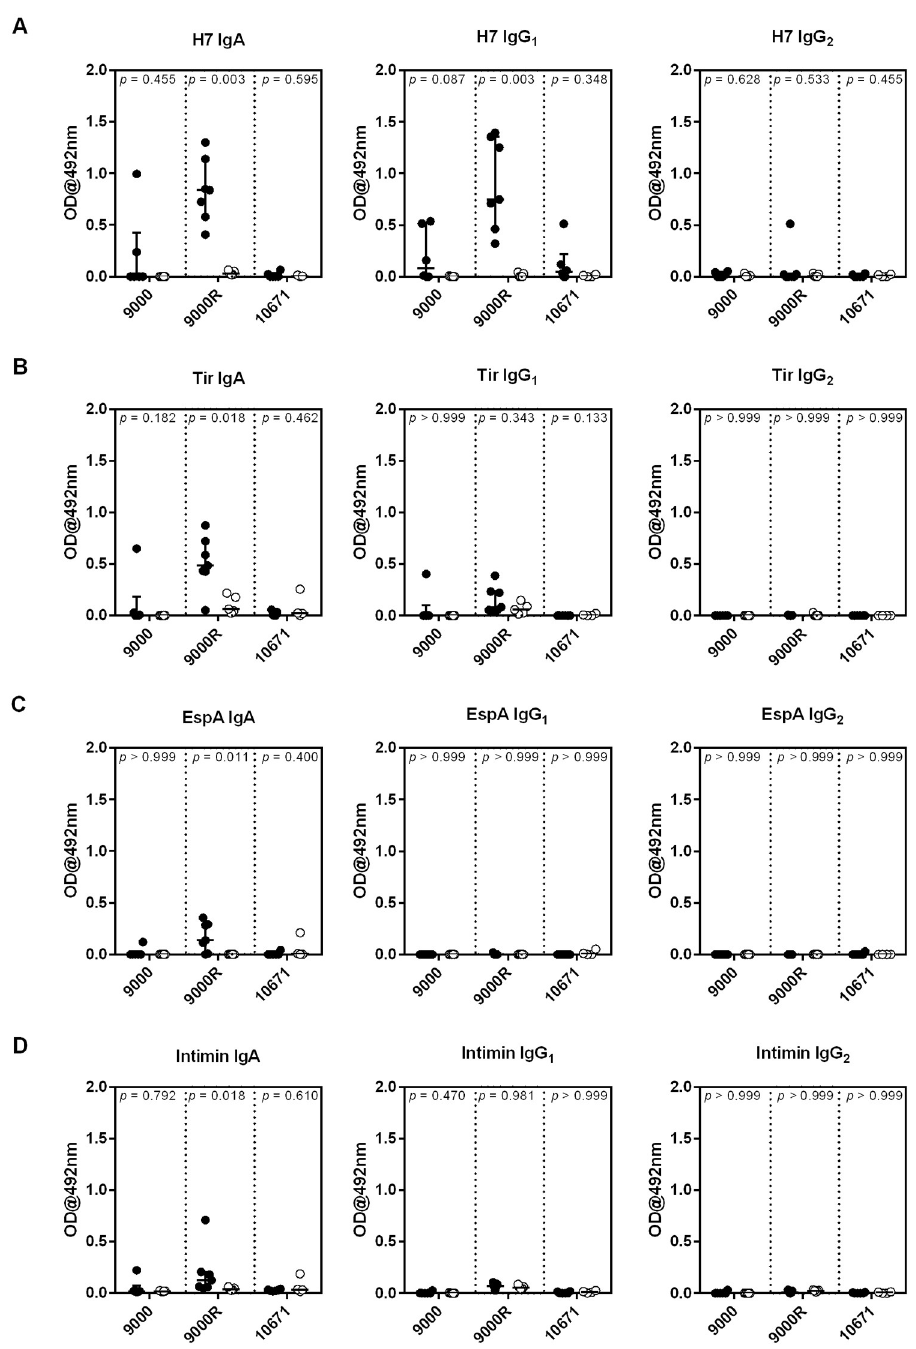
Fig 5. Enhanced rectal antibody responses to E . coli O157 antigens following challenge with a Stx2a + E . coli O157 strain. Antibody Secreting Cell (ASC) probes were generated from rectal lymph node cells isolated at post-mortem from calves orally challenged with ~10 9 cfu of E . coli O157 strains 9000, 9000R, and 10671 and from unchallenged control calves. Levels of (A) H7-specific; (B) Tir-specific; (C) EspA-specific and (D) Intimin-specific IgA, IgG 1 and IgG 2 within ASC probes quantified by ELISA. Each symbol represents an individual animal and medians and interquartile ranges are presented. Mann Whitney U- tests were used to compare antibody levels between challenged and unchallenged controls for each E . coli O157 strain and associated p -values are indicated.